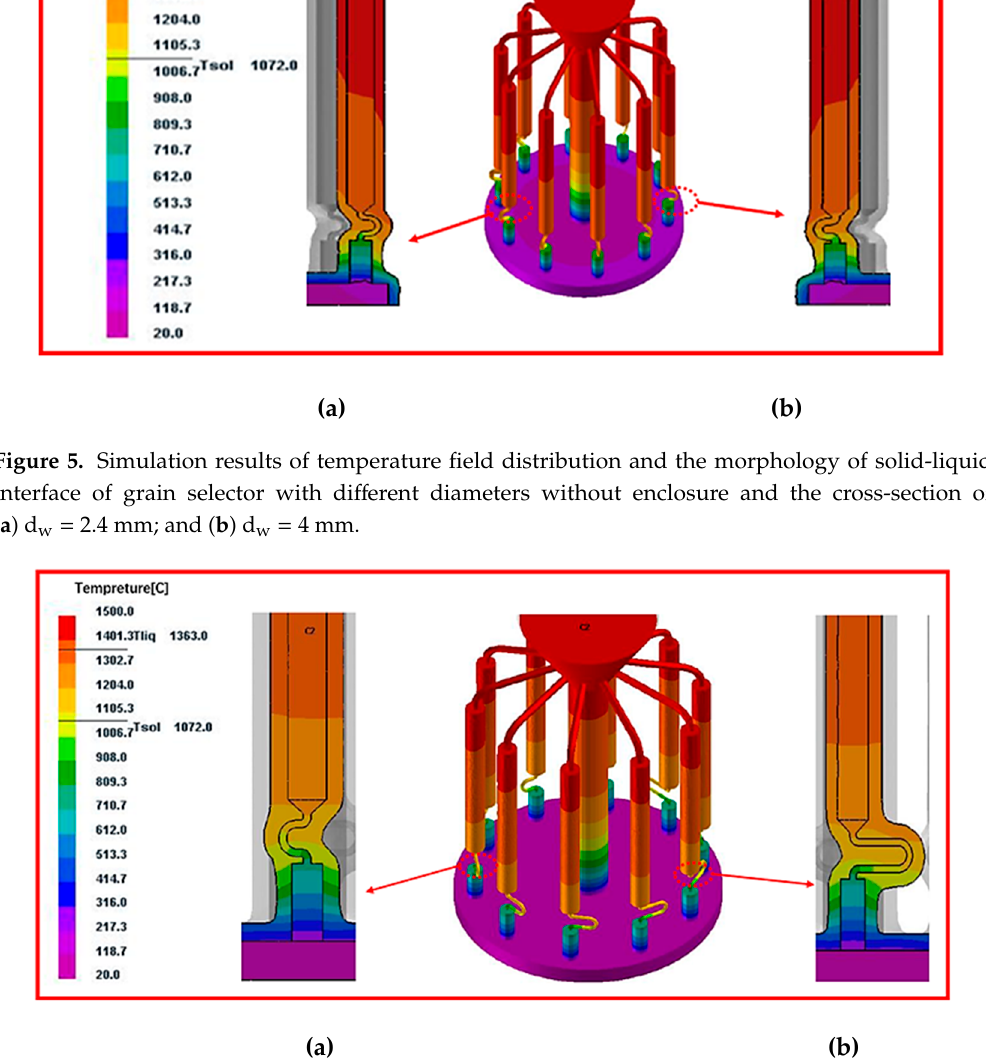
Figure 6. Simulation results of temperature field distribution and the morphology of solid-liquid interface of grain selector with different pitch length without enclosure and the cross-section of ( a ) d s = 4 mm and ( b ) d s = 20 mm.